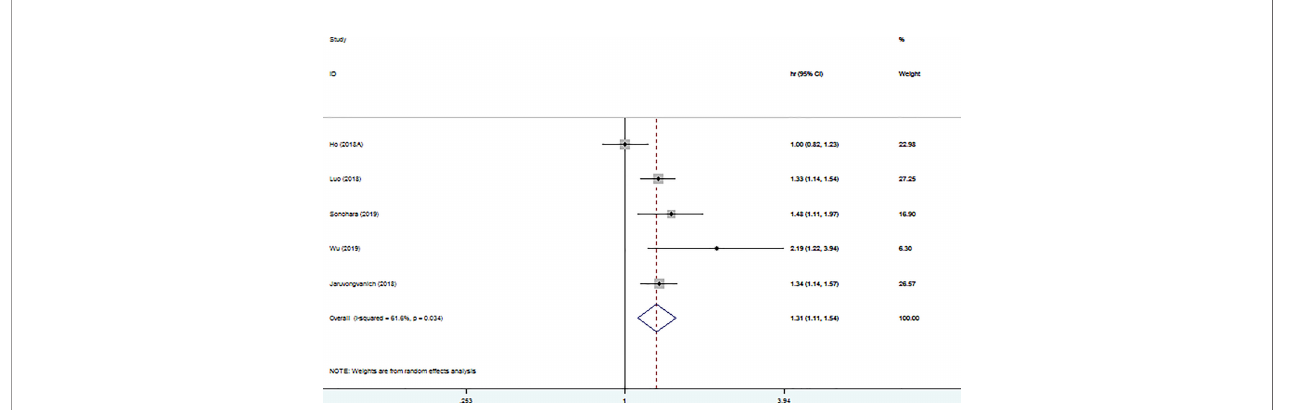
FIGURE 4 | Forest plot of the association between high PALBI grade and DFS/RFS.